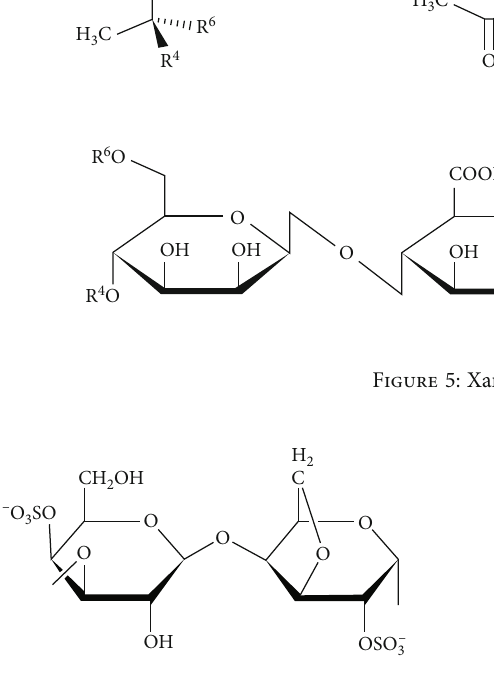
Figure 6: Carrageenan